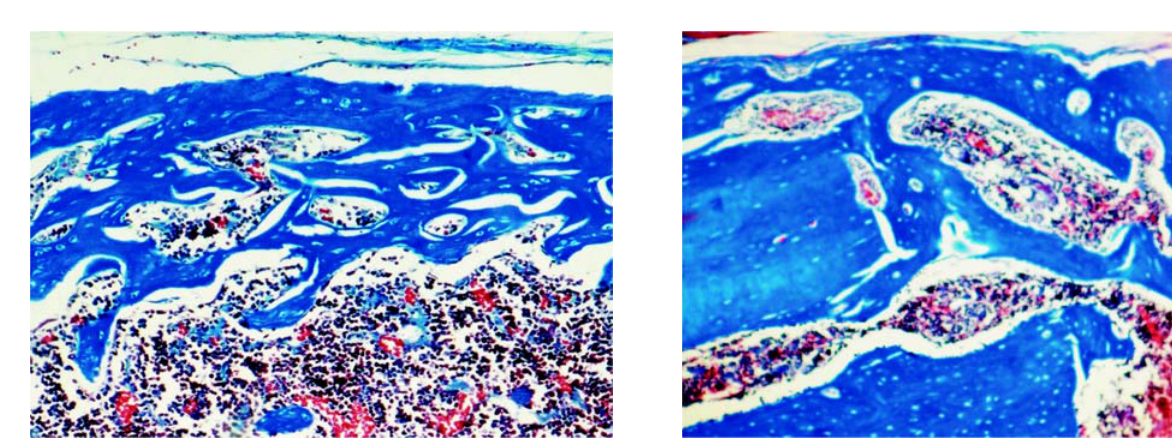
FIGURE 6- Group DG30: Bone grafts incorporated to the newly formed bone by thin bone trabeculae, with wide intratrabecular spaces and disorganized osteocyte lamellae. Masson’s Trichrome (Original magnification